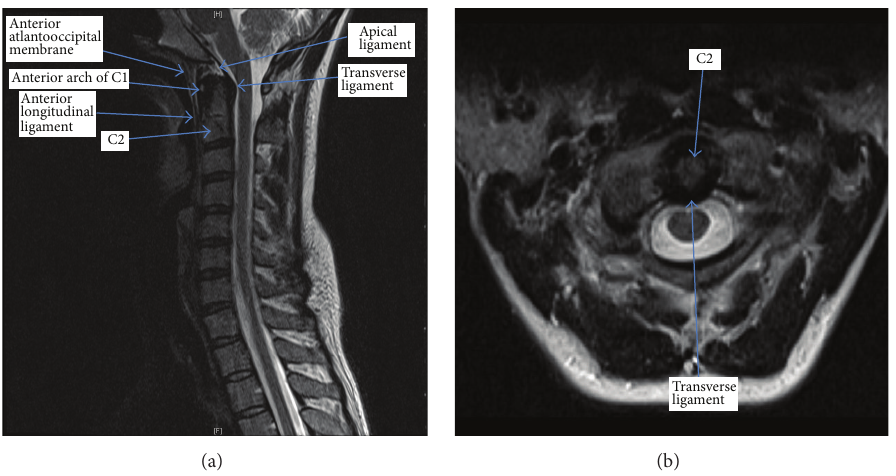
Figure 5: Sagittal (a) and axial (b) MRI images depicting the ligaments of the upper cervical spine.